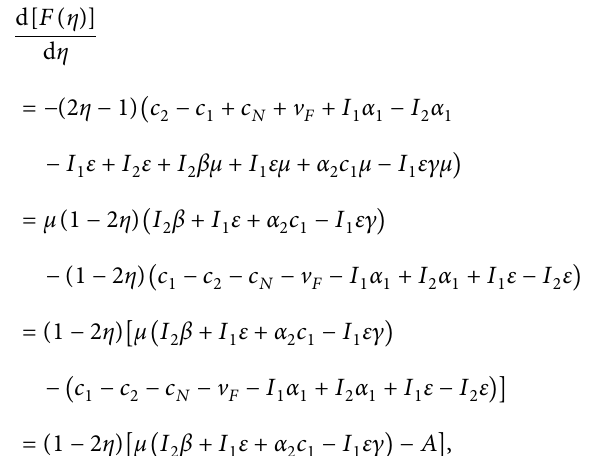
Figure 4: The evolution phase diagram of μ < μ ∗ .